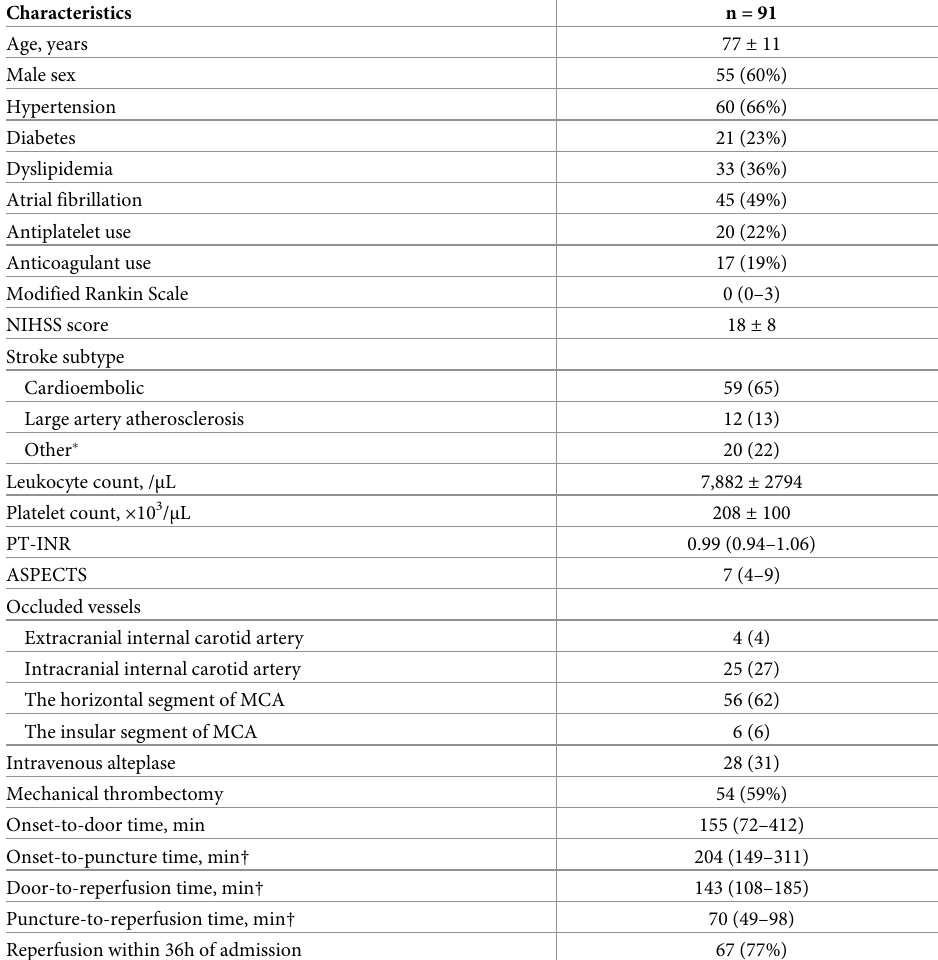
Table 1. Baseline patient